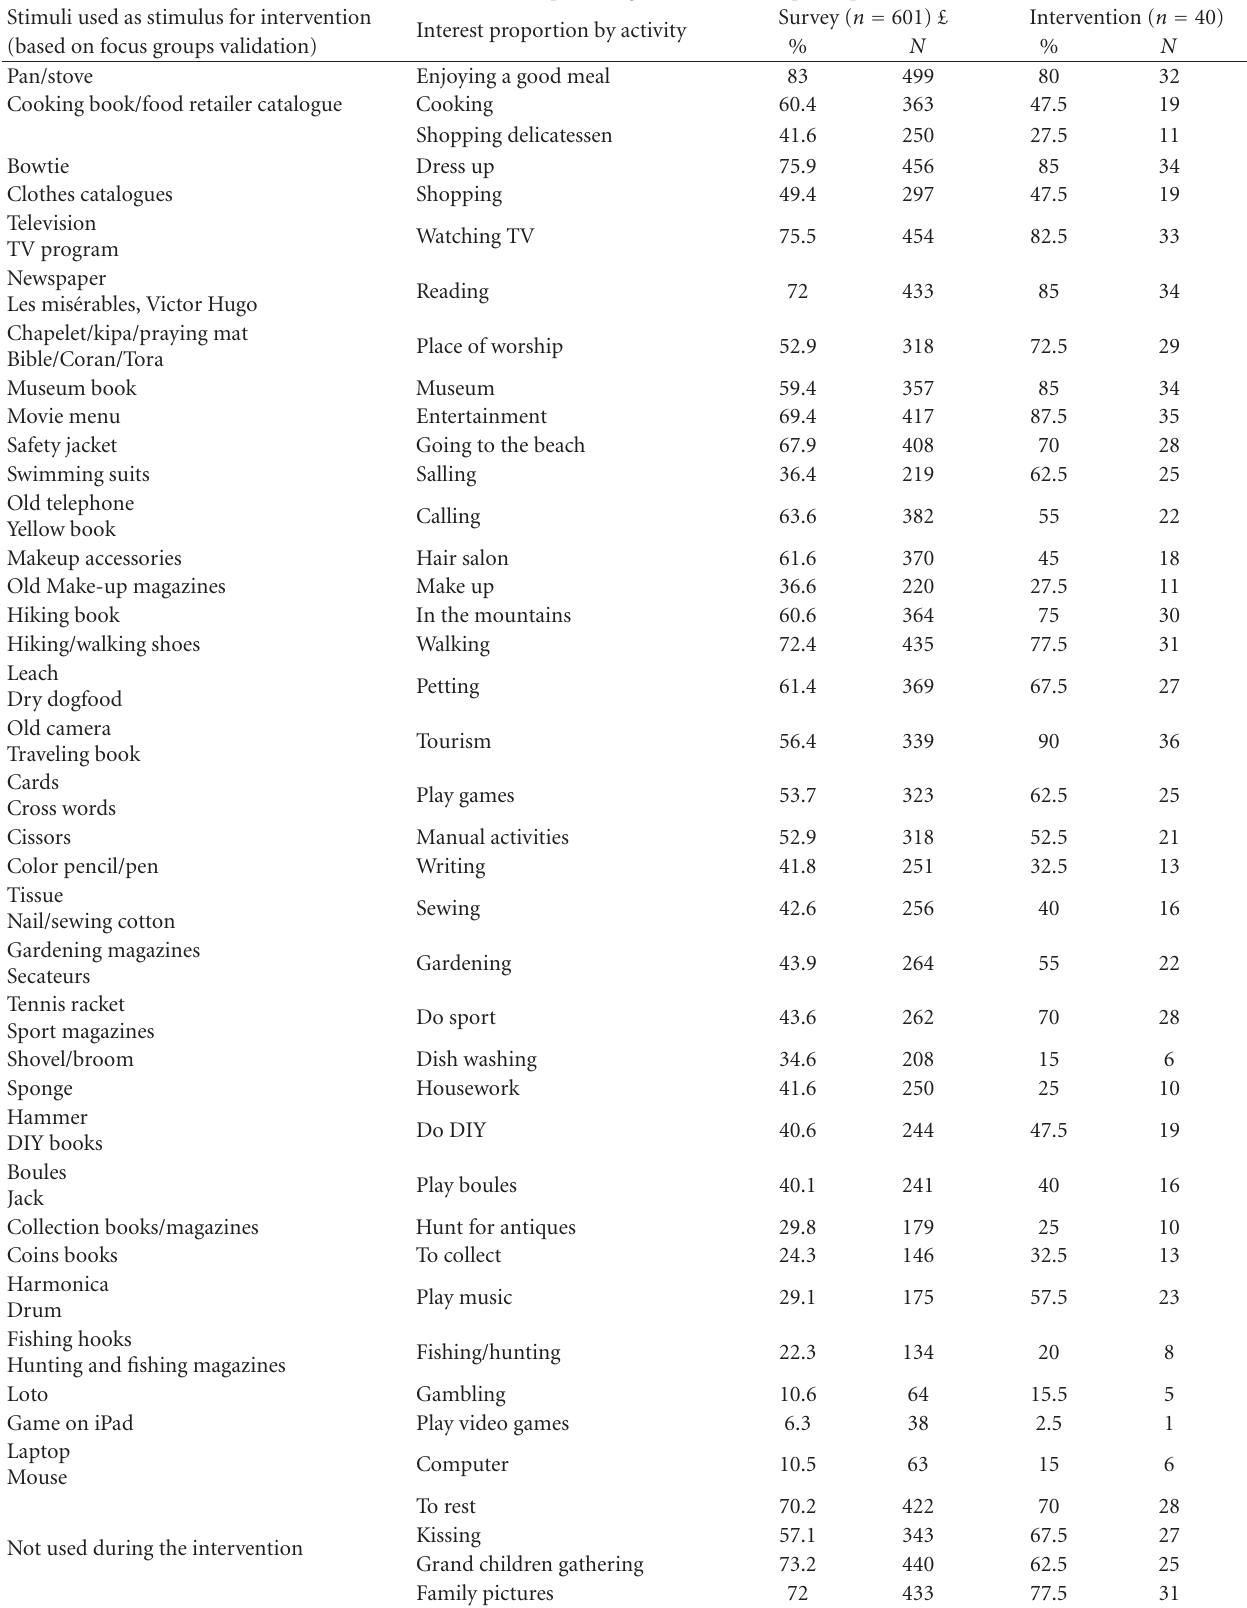
Table 1: List of 40 images of activities included in the TILT. Interest occurrence for the survey and the intervention study. ∗ Data from phase one from the protocol, involving 601 surveyed participants from nursing homes in France (work